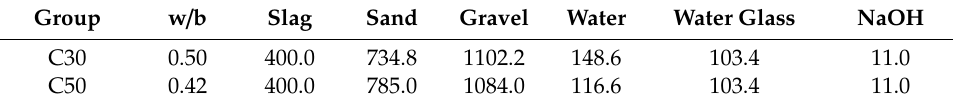
Table 6. Mixture proportion of AASC (kg / m 3 ).